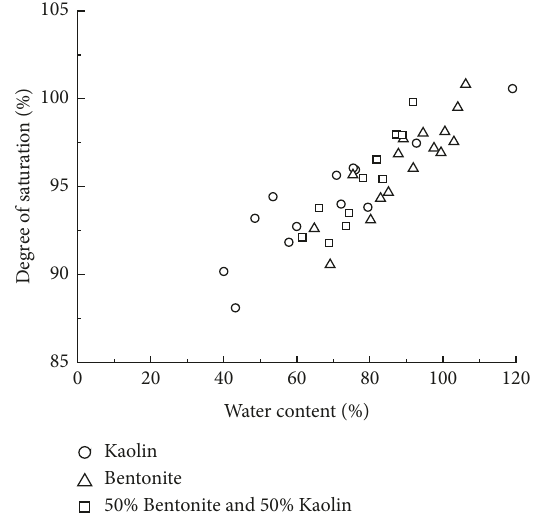
Figure 3: The degree of soil saturation during the test 1.